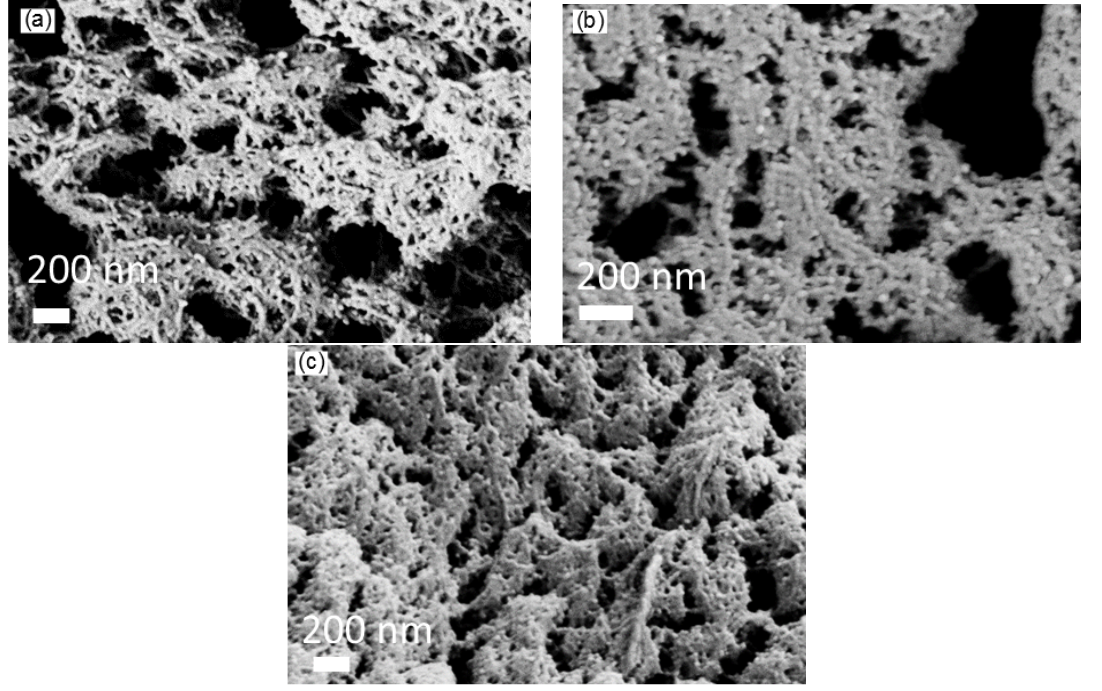
Figure 2. SEM images of amidated pectin aerogels with ( a ) 1 wt. %, ( b ) 2 wt. %, ( c ) 3 wt. % pectin